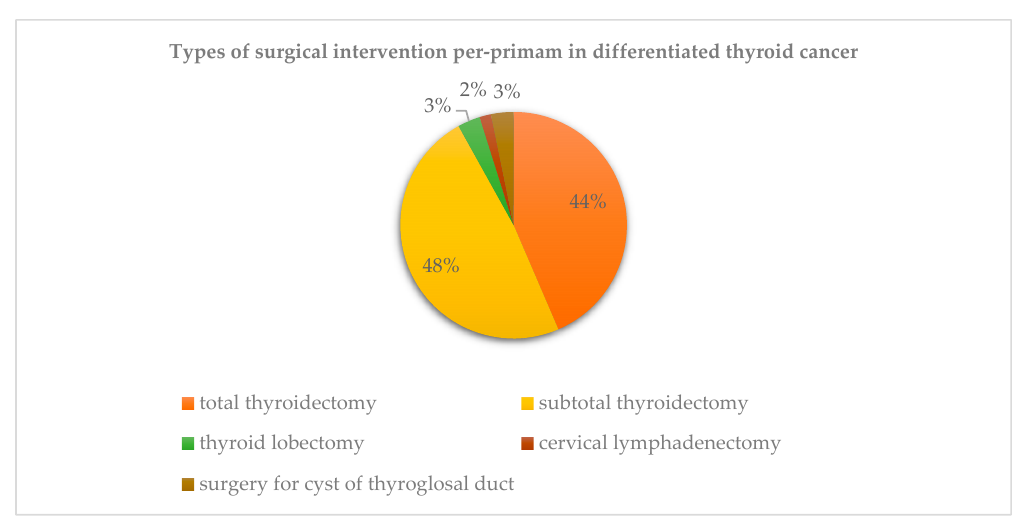
Figure 3. Types of the first surgical intervention in differentiated thyroid cancer.